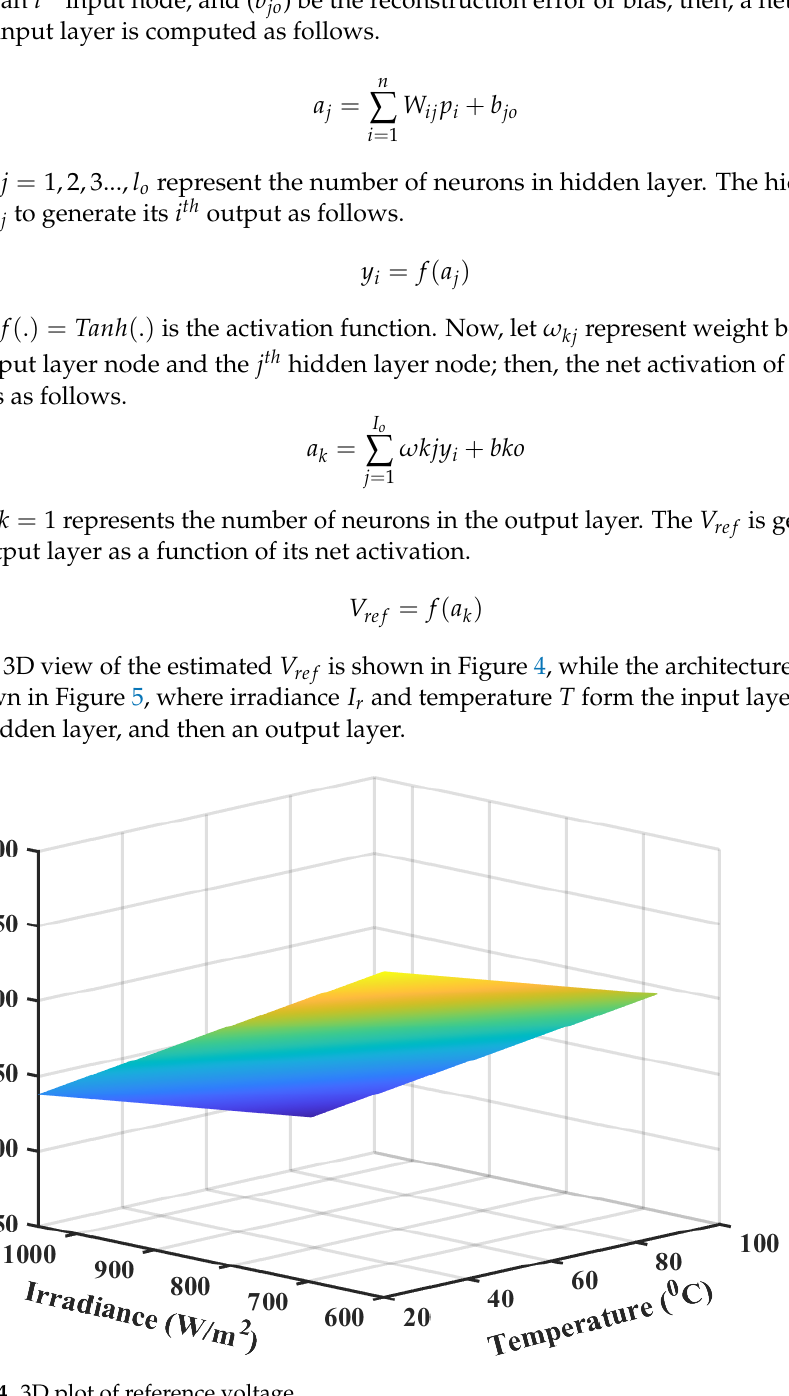
Figure 4. 3D plot of reference